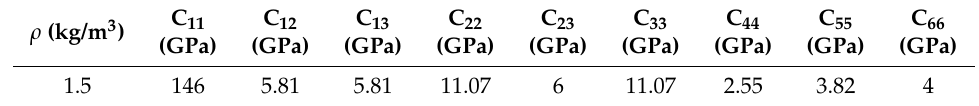
Figure 3. Shape of tested samples. Table 1. Density and elastic stiffness coefficients of carbon/epoxy composites.